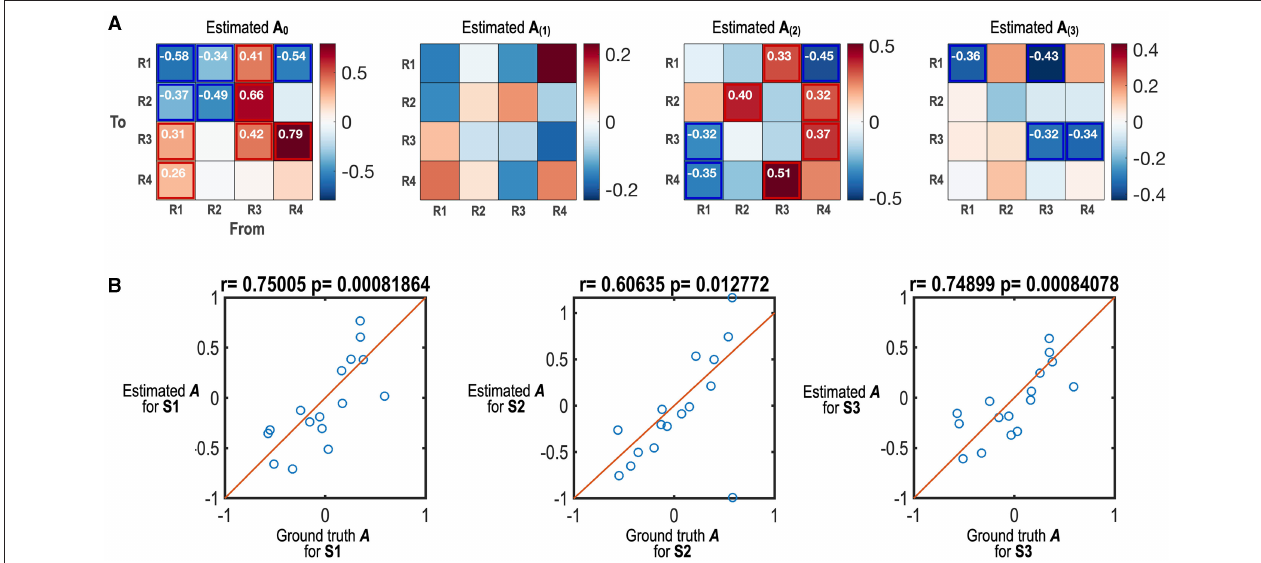
FIGURE 3 | Simulation results of the state-dependent effective connectivity estimation using HMM-MAR and spDCM. (A) The estimated state-dependent effective connectivity matrices (maximum a posteriori probability estimate; MAP) are displayed. A 0 indicates the offset or baseline effective connectivity for states S1, S2, and S3. A ( 1 ) , A ( 2 ) and A ( 3 ) indicate the MAPs corresponding to the regressors for S1, S2, and S3. The effect sizes that survived the criterion of 95% posterior confidence are shown in numbers and rectangles. (B) The scatter plots between estimated state-dependent effective connectivity and those of the ground truth are displayed. Estimated A for S1, S2, and S3 are a sum of A 0 and A ( 1 ) , a sum of A 0 and A ( 2 ) and a sum of A 0 and A ( 3 ) , respectively. Among the 48 network parameters, 38 parameters ( ∼ 80%) of the true parameters were in the range of 95% credible intervals of estimated